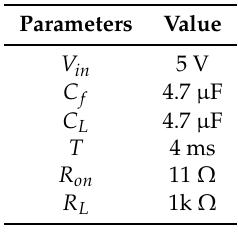
Table 1. Circuit parameters for optimization.